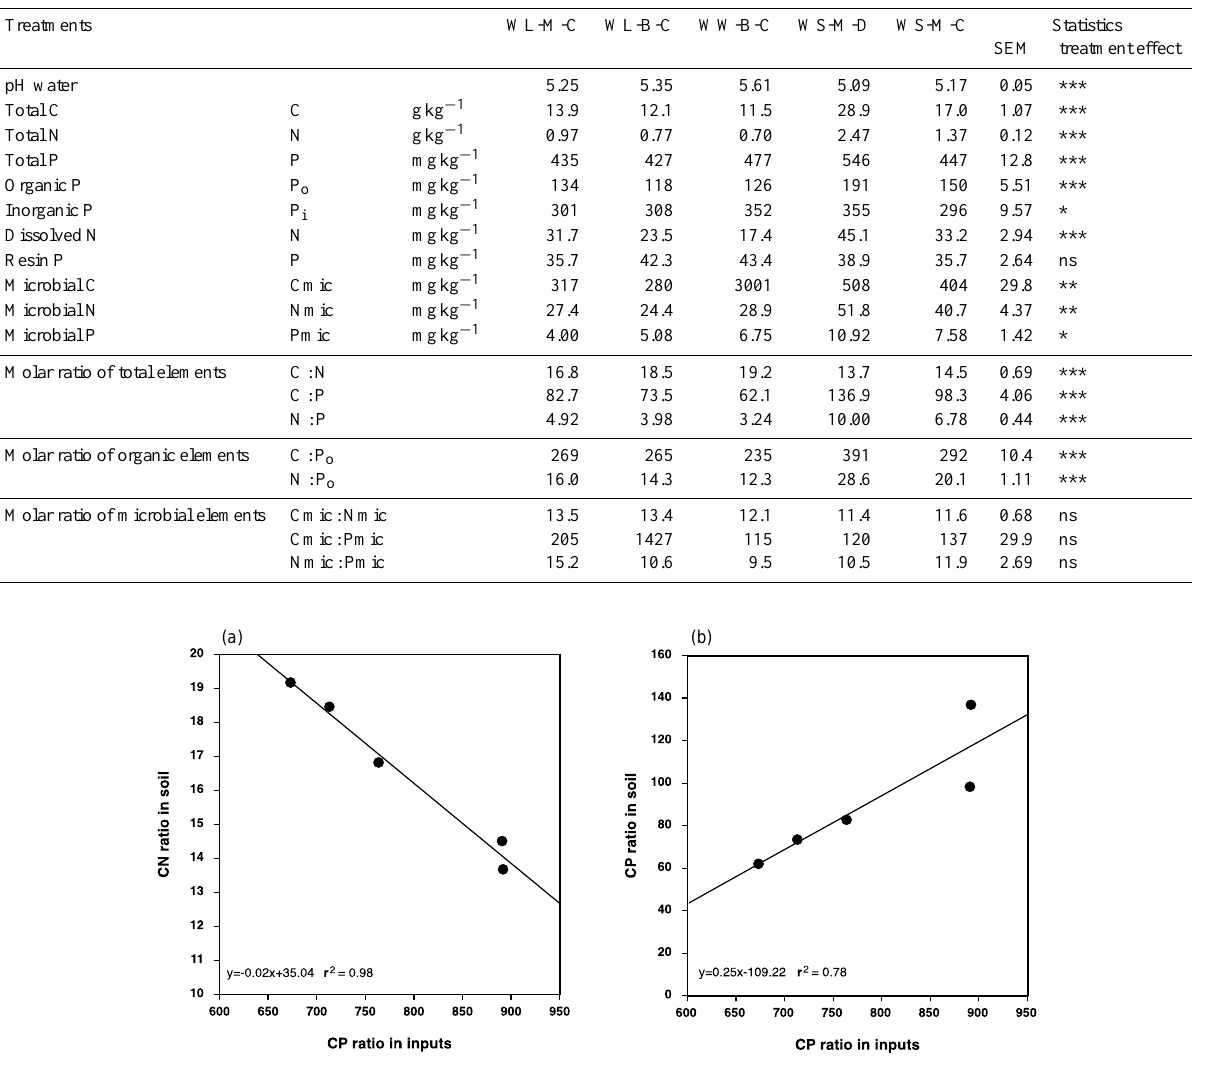
Figure 2. Relationships (a) between the C:P molar ratio in inputs and the soil C:N molar ratio and (b) between the C:P molar ratio in inputs and the soil C:P molar ratio in the Wagga Wagga field